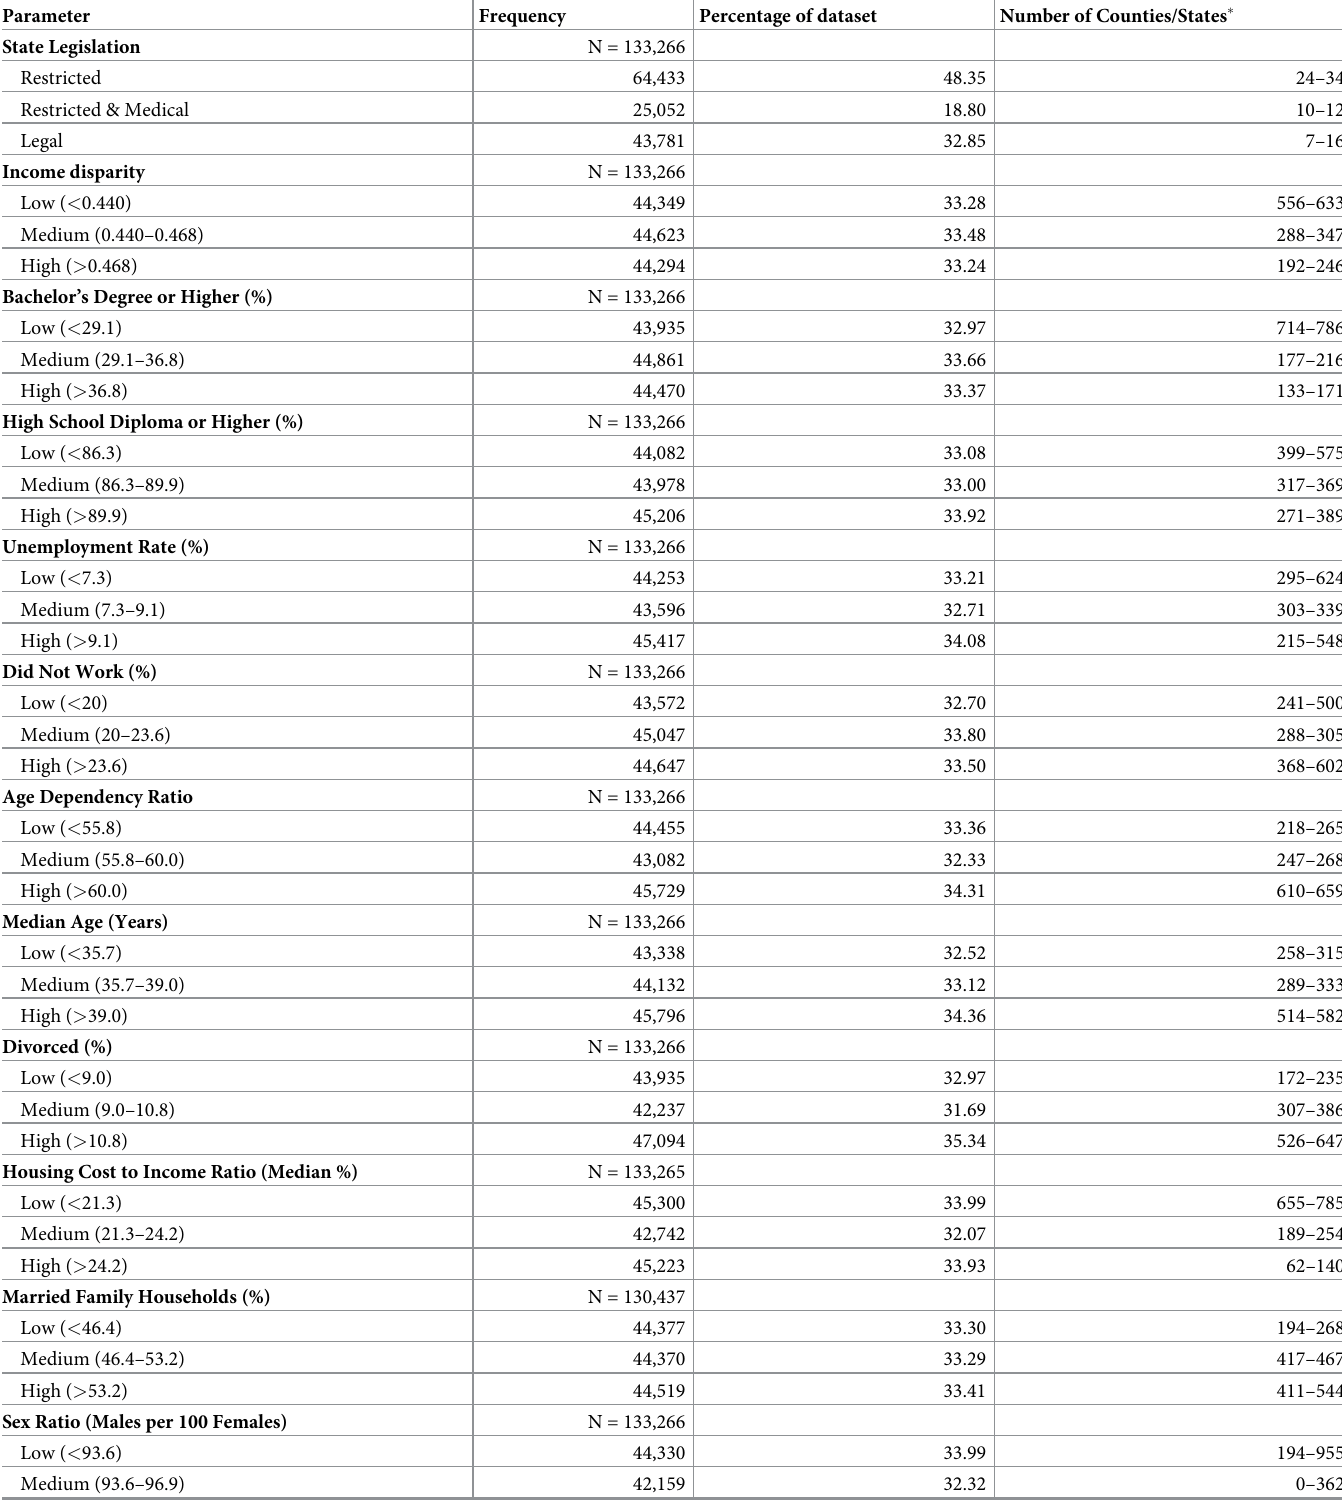
Table 3. The frequency of US dogs reported to the APCC a associated with each county and state-level variable